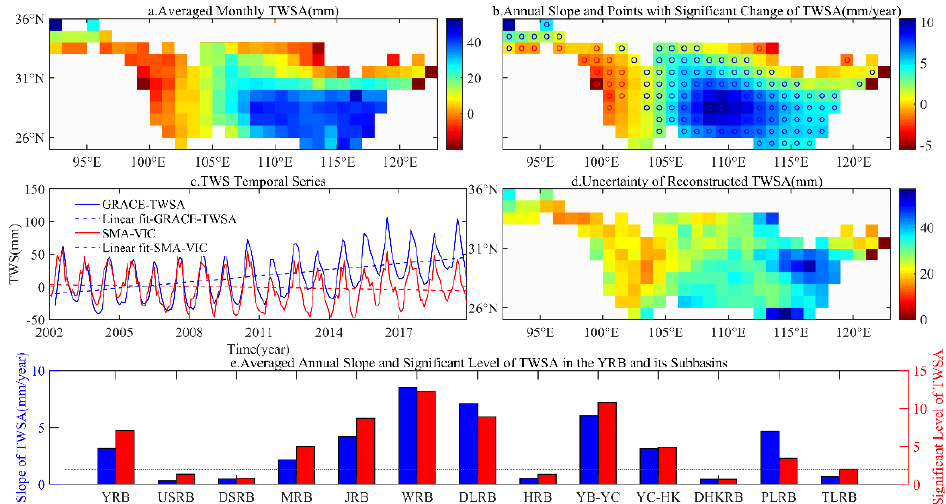
Figure 3. Slope of GRACE-TWSA and VIC-SMA in the YRB during April 2002–December 2019. ( a – d ) are averaged monthly GRACE-TWSA, slope and related points with significant trend, time series of GRACE-TWSA and VIC-SMA, annual slope and significant level, respectively. ( e ) represents the slope and significant level of TWSA in whole YRB and its sub-basins. The red circle and the blue circle represent significant decrease and significant increase, respectively).